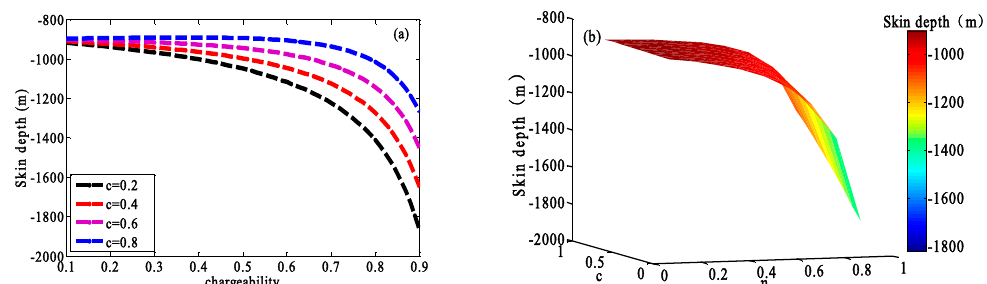
Figure 9. The effect of the chargeability and the frequency dependence on the skin depth (( a ) 2D curve, ( b ) 3D view)